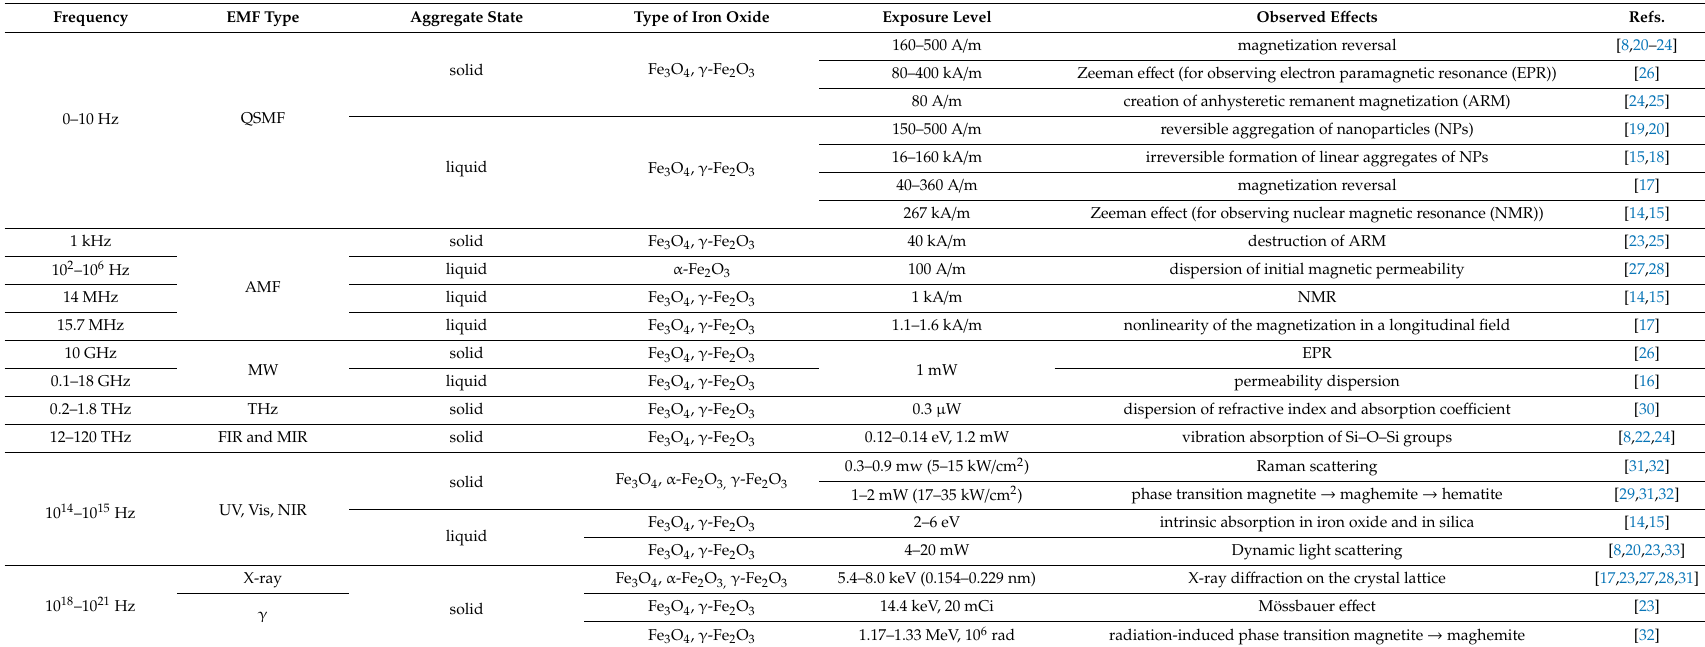
Table 1. Physical e ff ects observed during the interaction of nanocomposites based on the Fe m O n –SiO 2 system with various types of electromagnetic fields